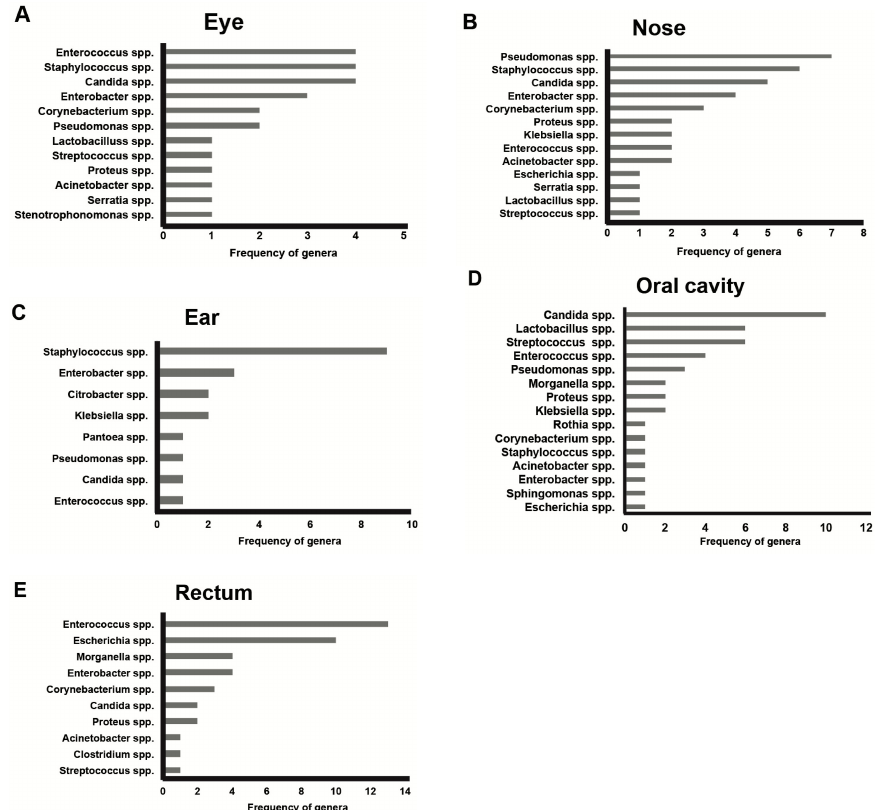
Figure 1. The distribution of genera among the five external anatomical sites: ( A ) eye; ( B ) nose; ( C ) ear; ( D ) oral cavity and ( E ) rectum.